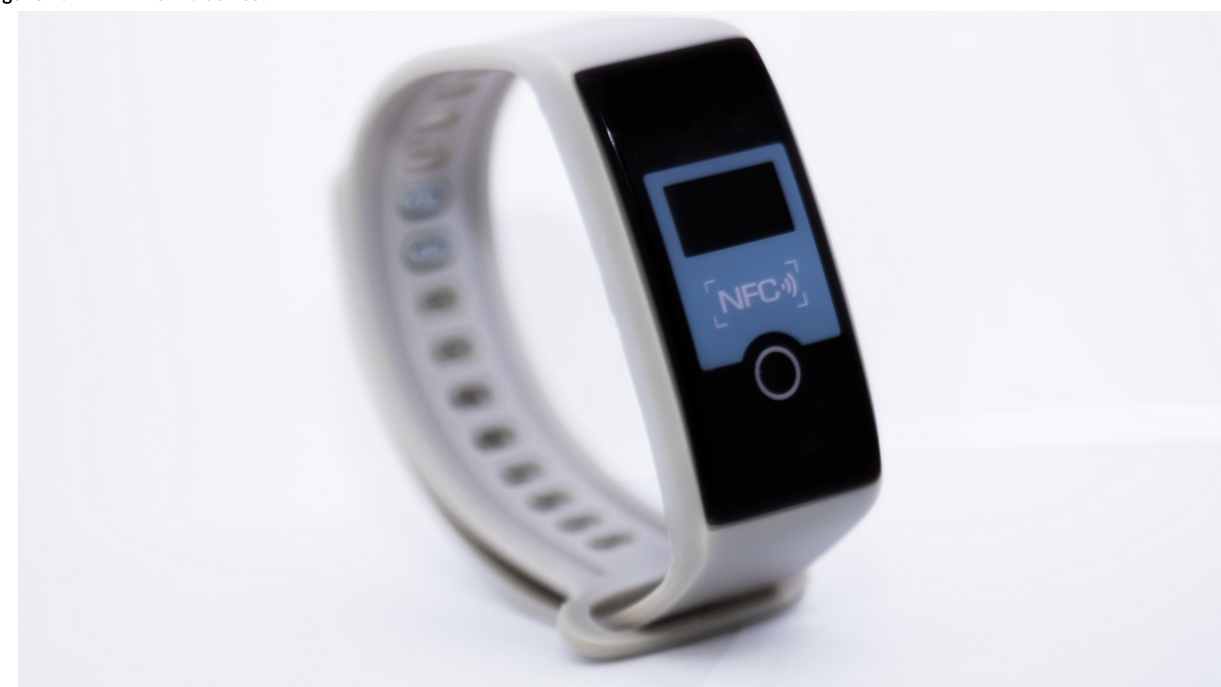
Figure 2. HEARThermo